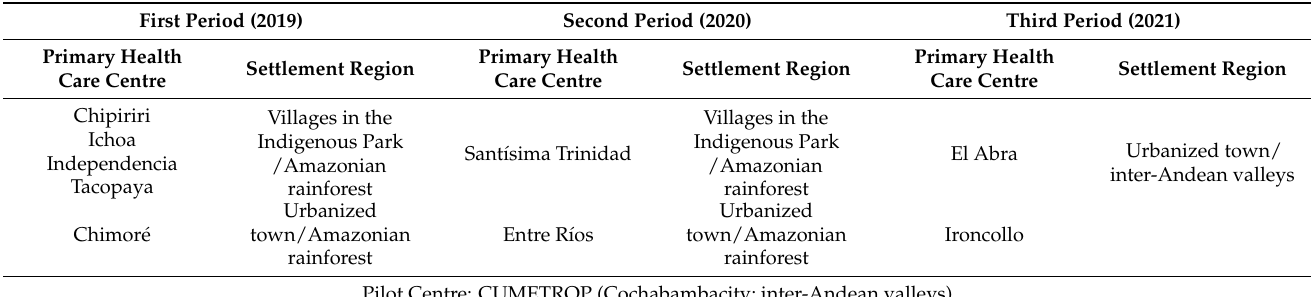
Table 1. Distribution of primary health care centres involved in the meglumine antimoniate intrale- sional application in intervention period.